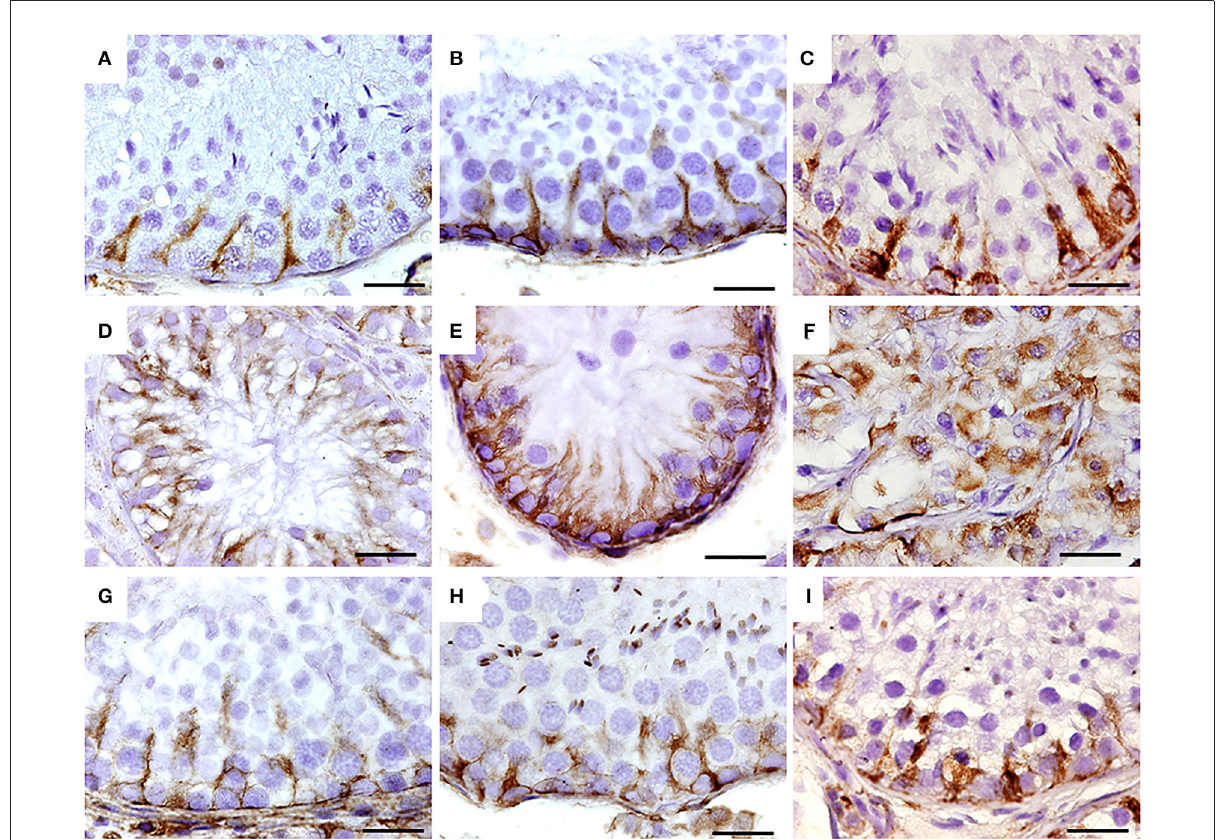
FIGURE5 Immunohistochemistry for vimentin in seminiferous tubes of dogs from the control group (CTRL) (A–C) ; from cryptorchidism (CO) (D–F) and contralateral (CONTRA) (G–I) in the peripubertal stages (first column); young adult (second column) and senile (third column). A marked immunoreactivity is observed in all stages of development with variation in its distribution, mainly in animals with CO. Bar scale: 50 µ